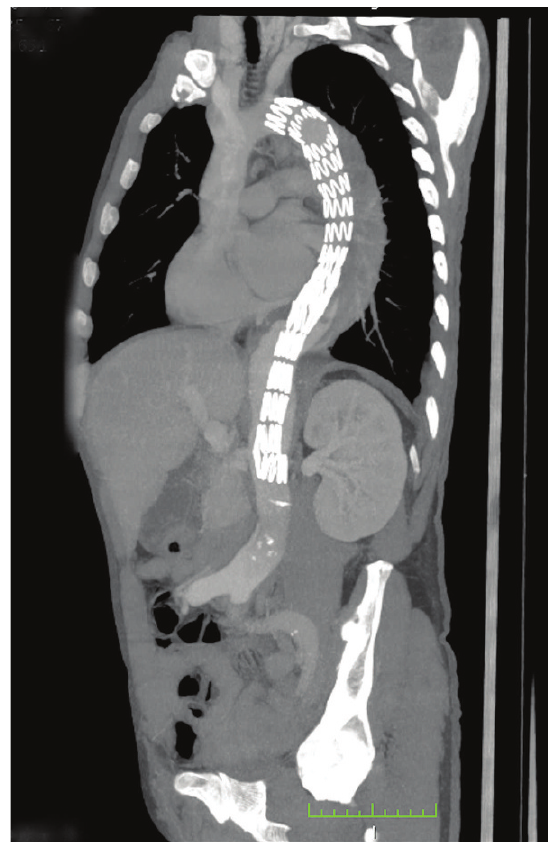
Figure 7 - Chronic dissection of thoracic aorta. Angiotomographic